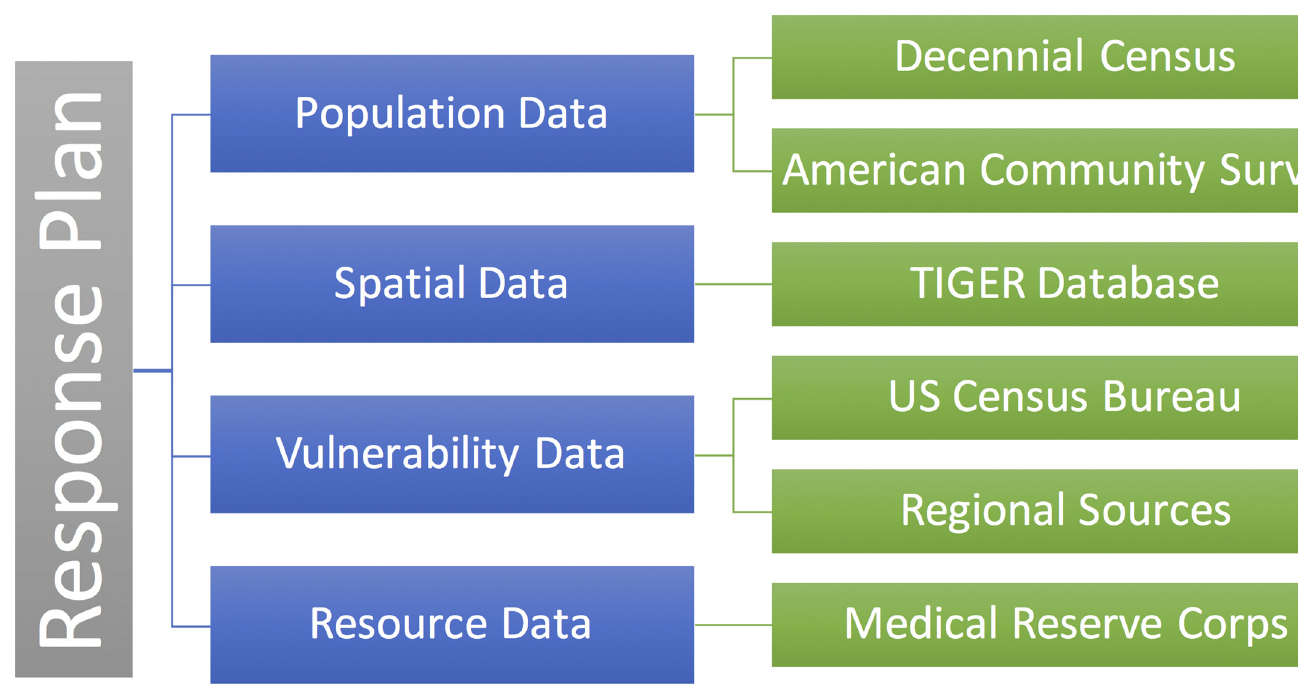
Fig 3. Data Management. Overview of the different data sources utilized and their interplay.